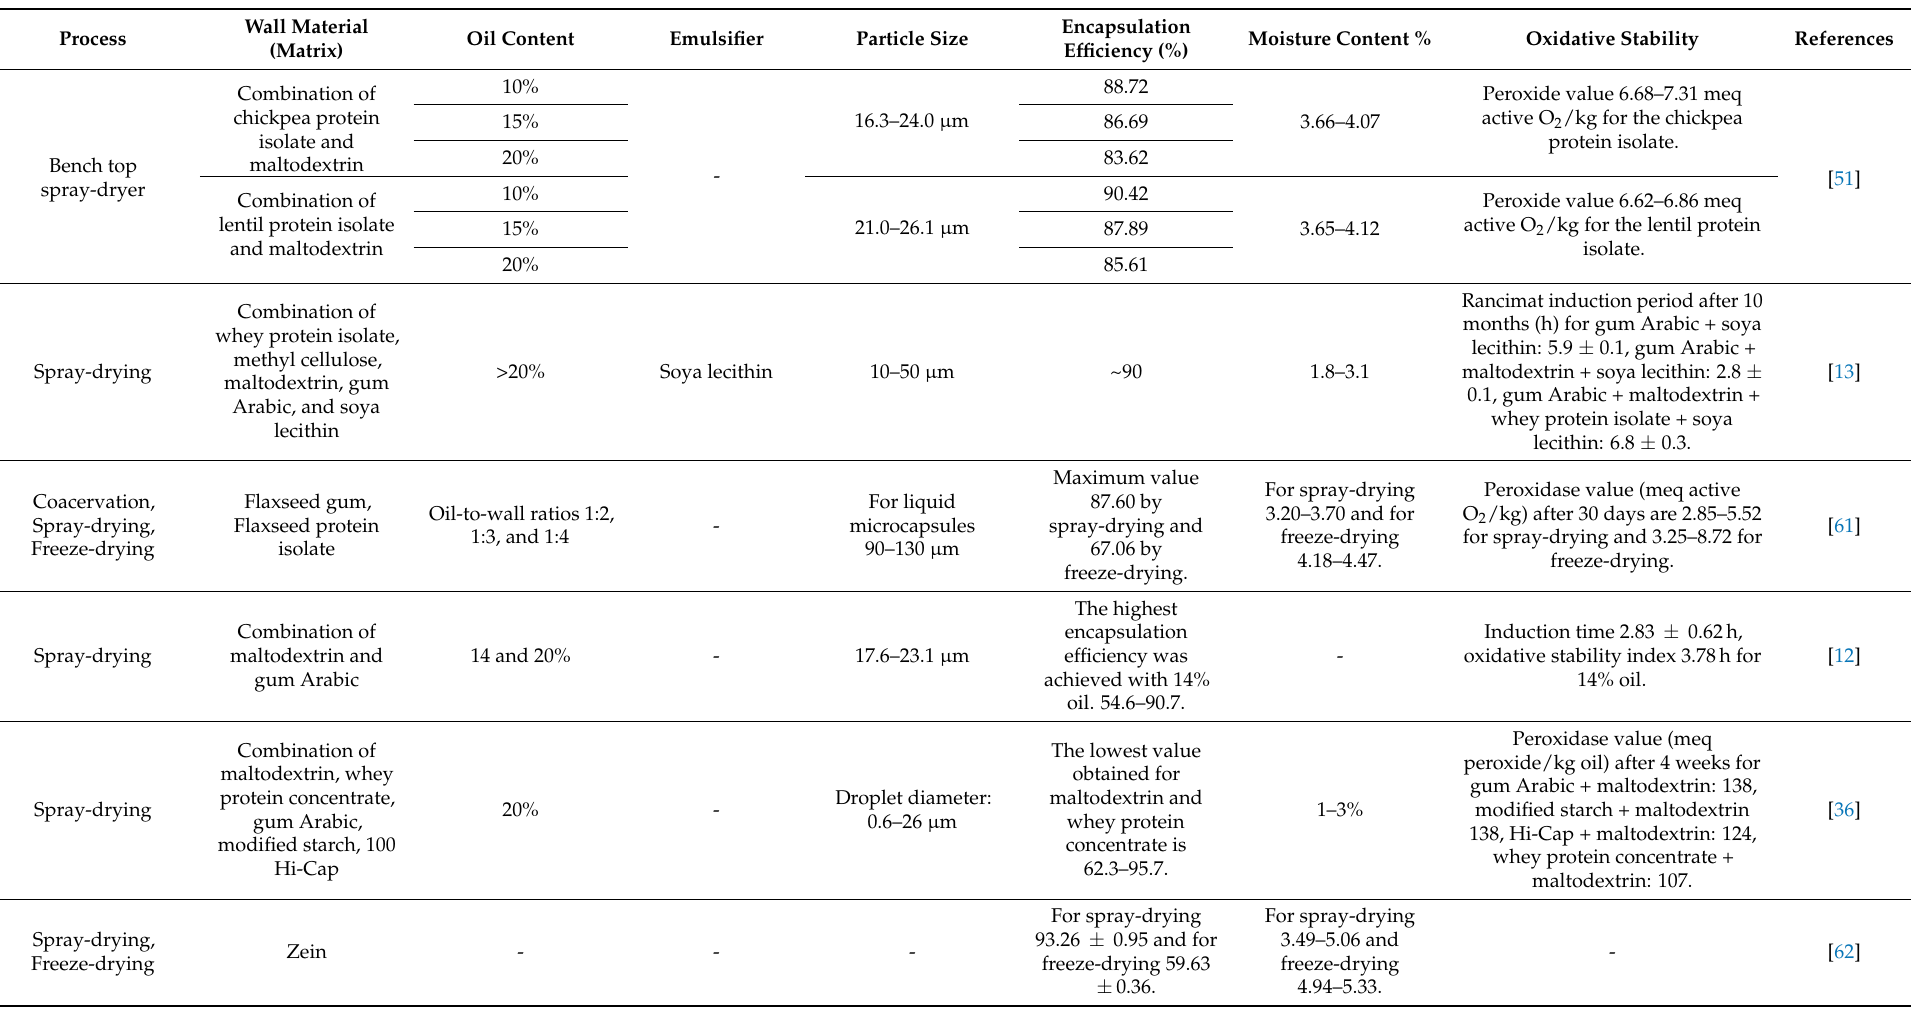
Table 3. Process conditions for producing the encapsulated flaxseed oil and their biochemical